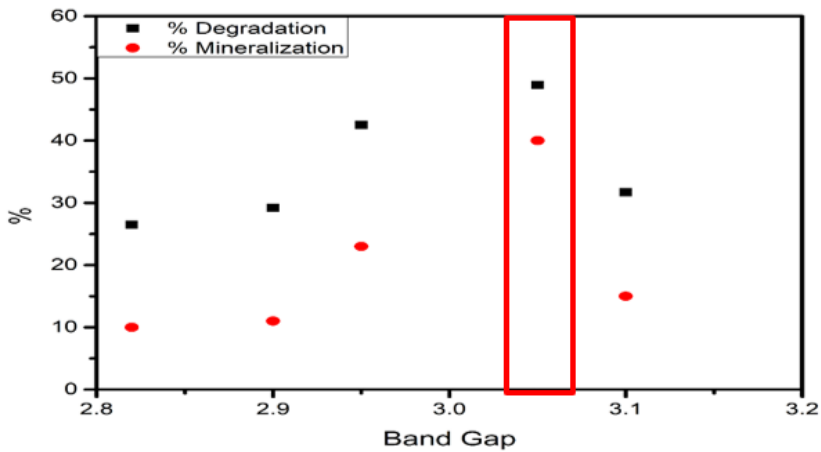
Figure 20. Sulphide band gap vs. degradation and mineralization ratio.